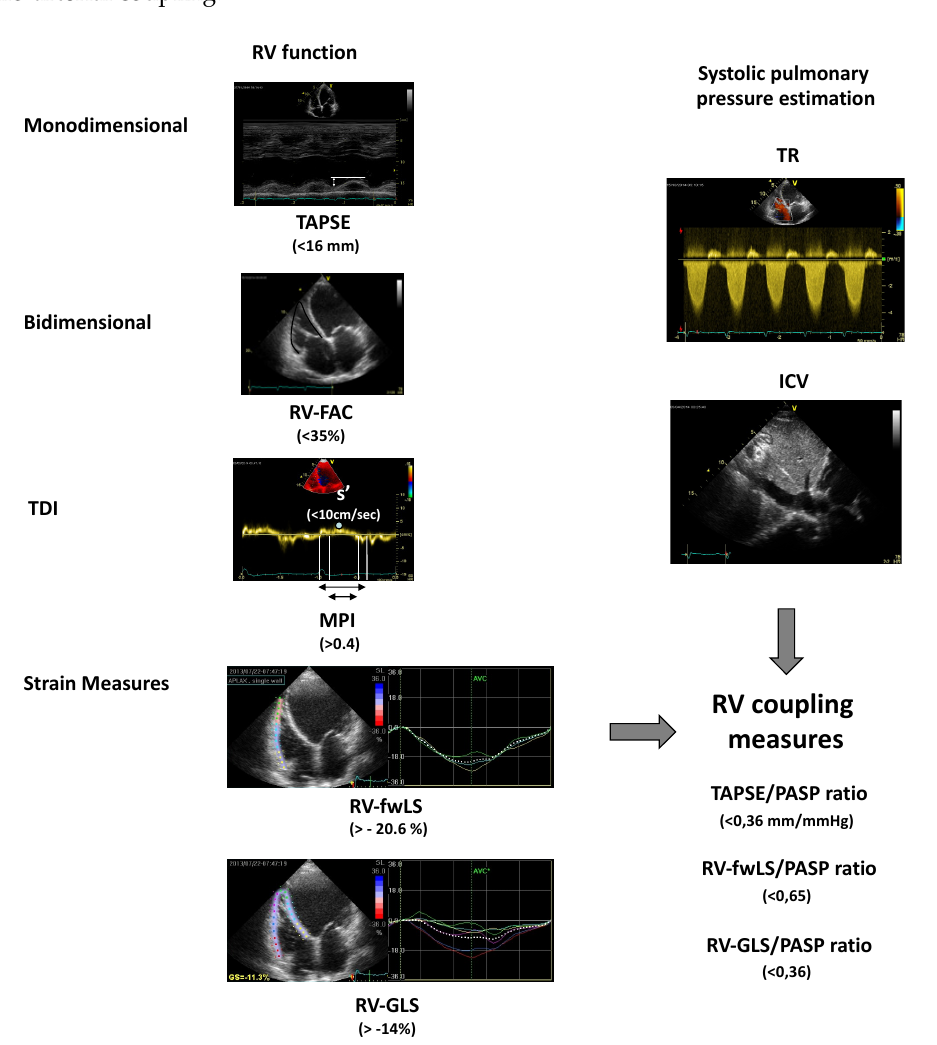
Figure 2. Echocardiographic measures of right ventricle function and right ventriculo-arterial coupling. Between brackets, the values associated with a worse prognosis are reported. ICV: inferior cava vein; MPI: myocardial performance index; PASP: estimated Pulmonary Arterial Systolic Pressure; RV: right ventricle; RV-FAC: right ventricle fractional area change; RV-GLS: RV global longitudinal strain; RV-fwLS: RV free wall longitudinal strain; s’: tricuspid systolic peak at TDI; TAPSE: tricuspid annular plane systolic excursion; TDI: Tissue Doppler Imaging; TR: tricuspid regurgitation.